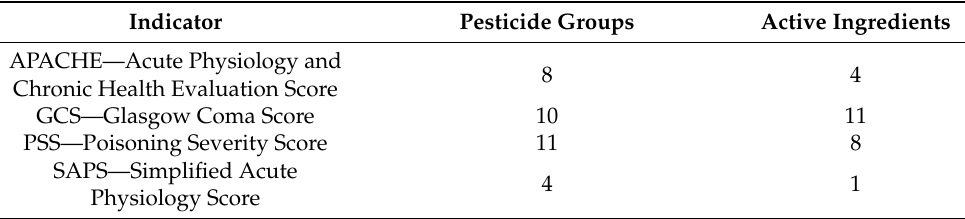
Table 5. Reported indicators for the severity of